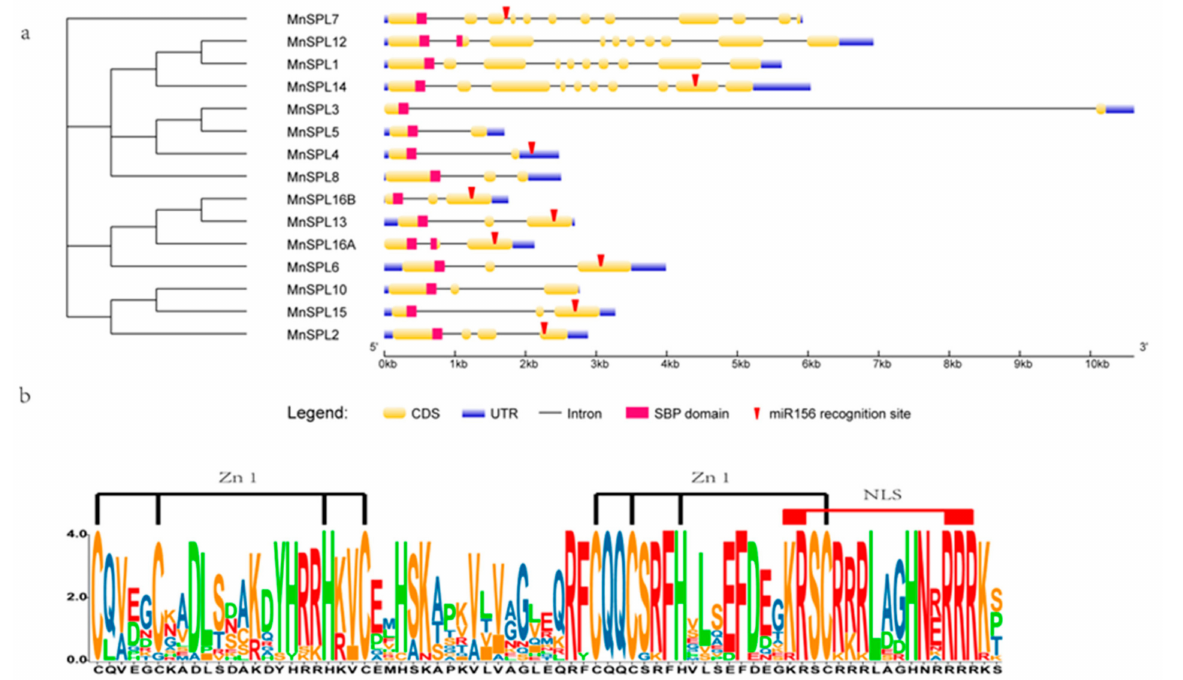
Figure 3. The structures of the full-length SPL genes in mulberry. ( a ) Gene structure diagram of MnSPL genes. ( b ) Sequence logo of the SBP domain of MnSPLs. The height of the letter (amino acid) at each position represents the degree of conservation.